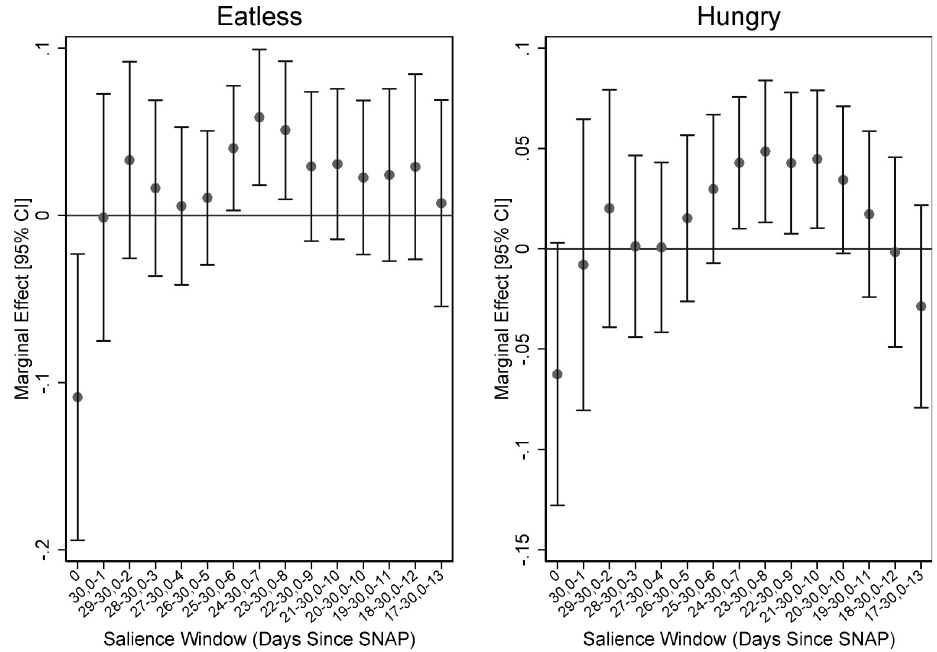
Fig 2. Varying the bounds of salience window: FSM items eatless and hungry. Source: Authors’ calculations using NHANES data. N = 7,919. Regression estimates are weighted.